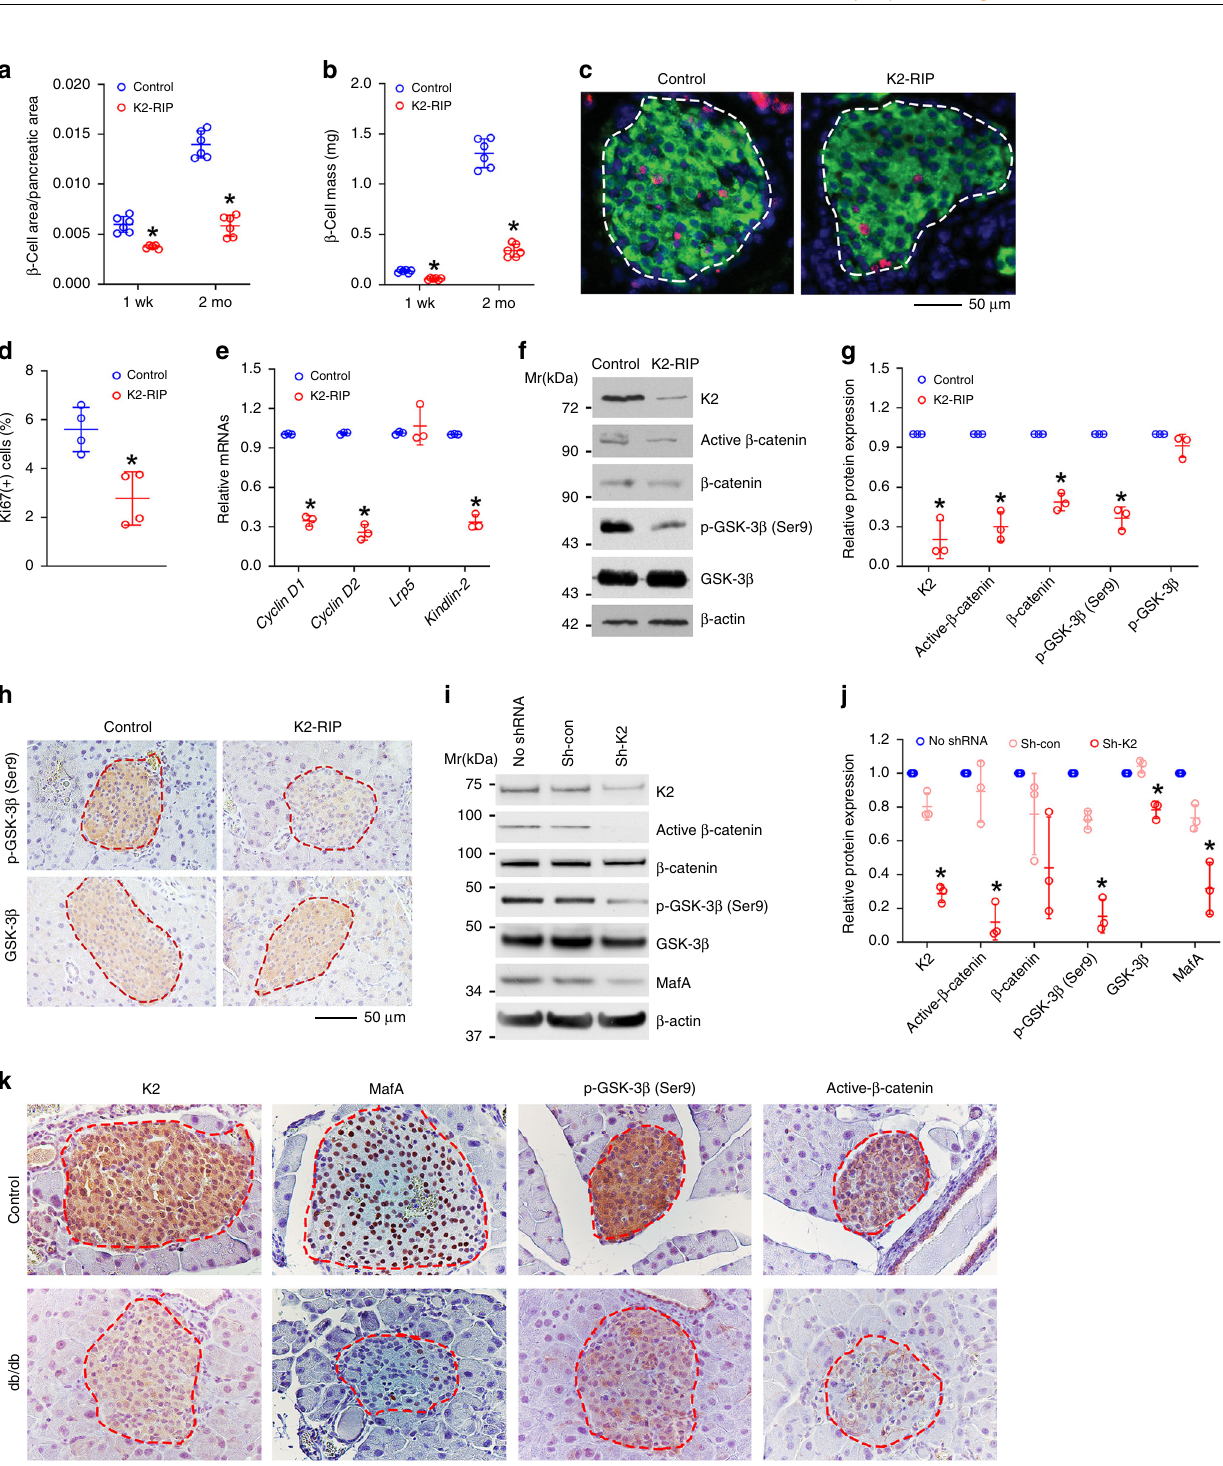
abolished the Kindlin-2 activation of the Ins1 promoter (Fig. 5e, bottom). Kindlin-2 interacts with and stabilizes MafA protein . We next determined whether Kindlin-2 interacts with MafA by immunoprecipitation (IP) assays using extracts from COS-7 cells overexpressing Flag-Kindlin-2 and HA-MafA. Results showed that MafA protein was present in an anti-Kindlin-2